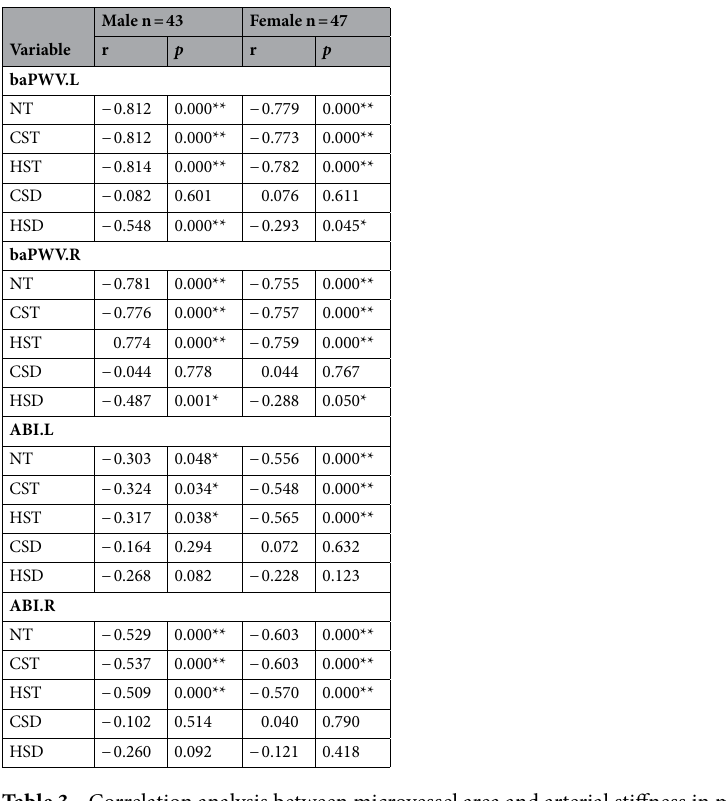
Table 3. Correlation analysis between microvessel area and arterial stiffness in males and